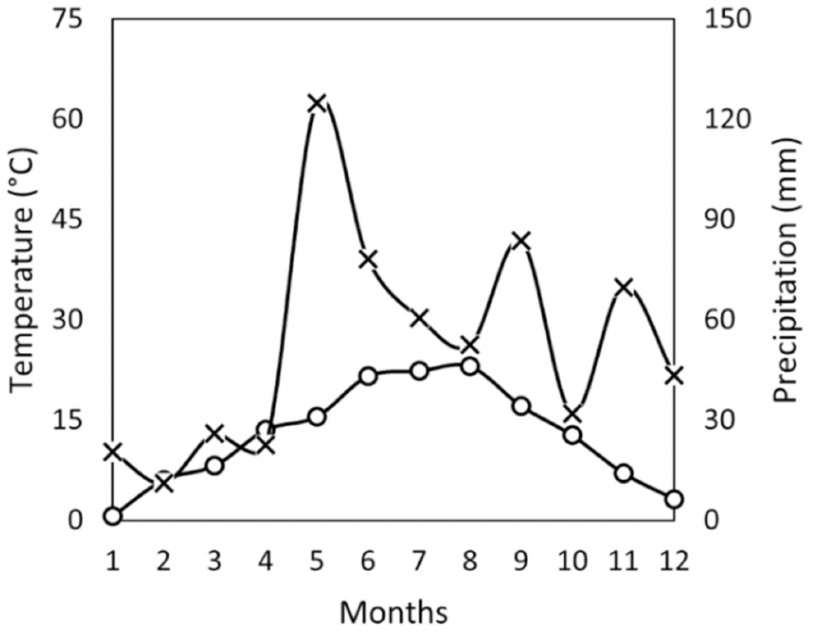
Figure 7. Ombrothermic diagram, which summarizes trends in temperature (O) and precipitation (X) of two years of